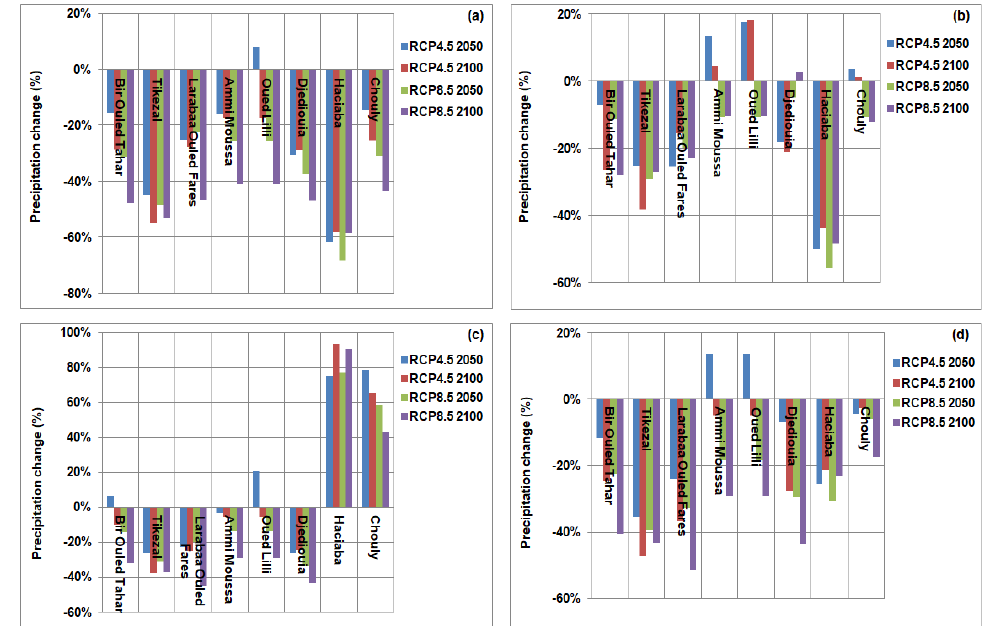
Figure 4. Changes in autumn precipitation relative to the historical period under two scenarios (RCP4.5 and RCP8.5): ( a ) quantile mapping, ( b ) scaled distribution mapping, ( c ) quantile delta mapping, and ( d ) model (RAW).